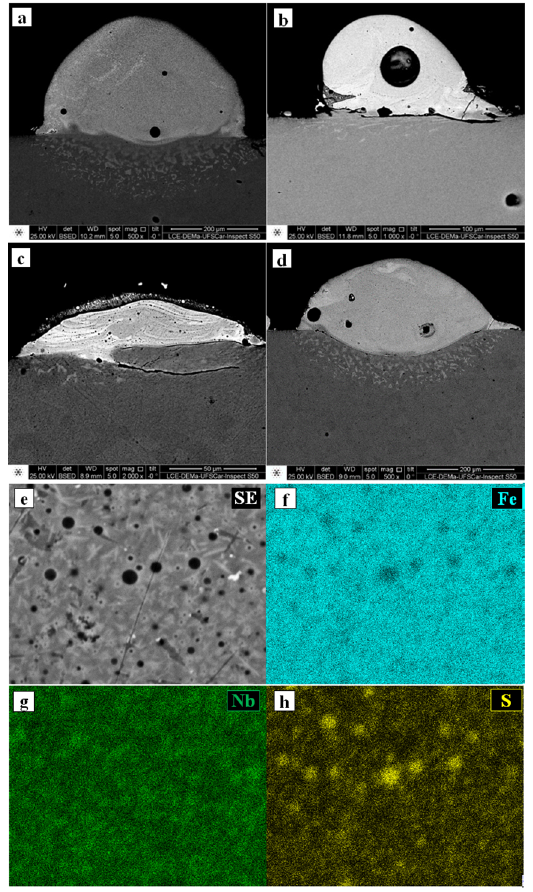
Cr Nb B (at%) + 60 8 8 24